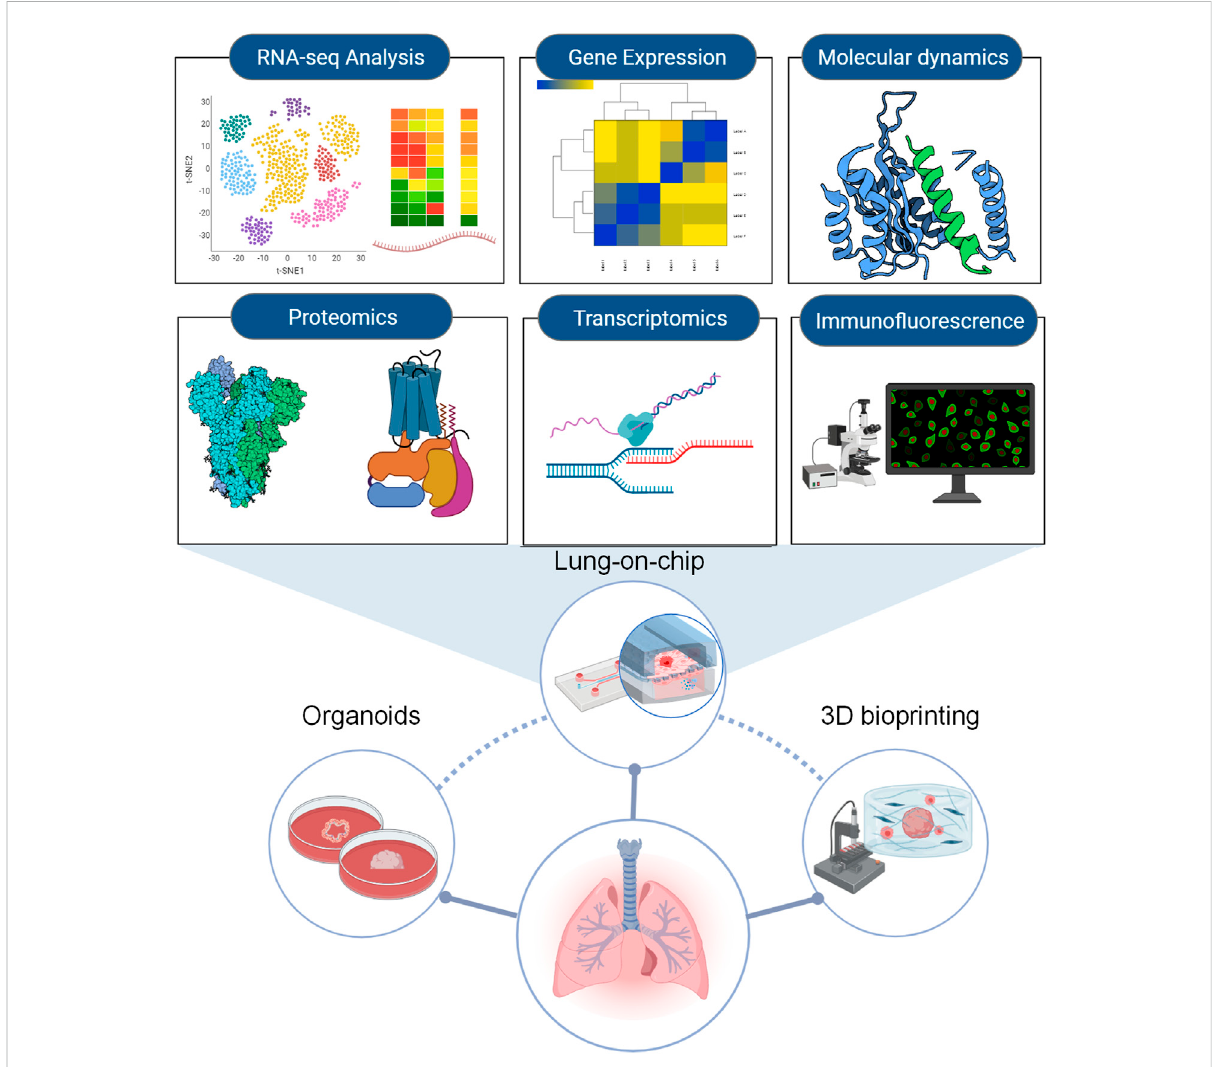
FIGURE 5 An overview of assays for screening agents to combat SARS-CoV-2 with 3D